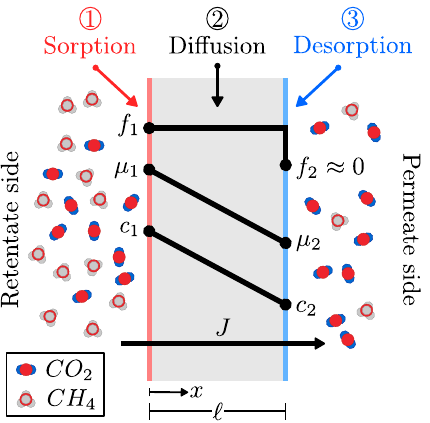
Figure 1. Schematic representation of gas permeation through the solution-diffusion mechanism.